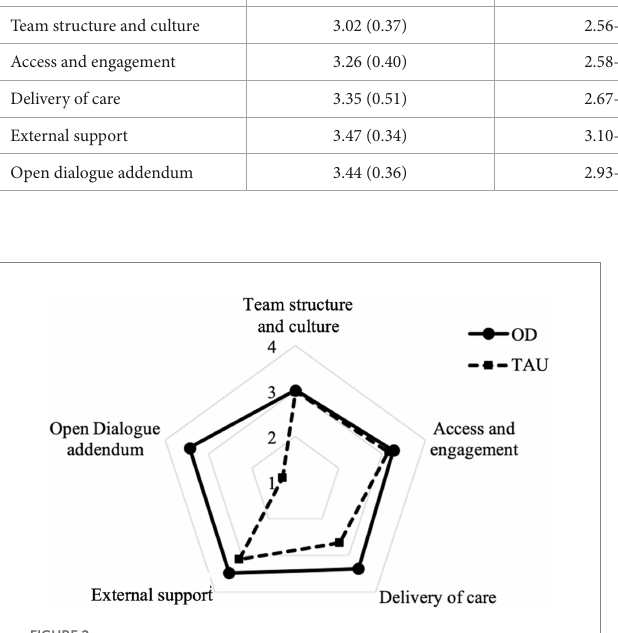
FIGURE 2 Comparison of mean COM-FIDE section scores between Open Dialogue (OD) and standard care